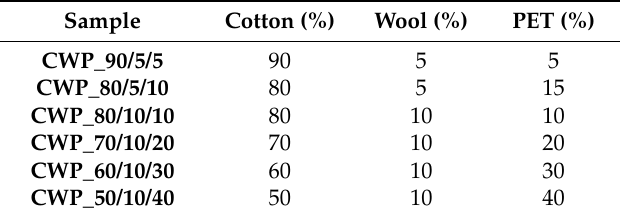
Table 1. Composition of artificial blended textile samples in weight Table 1 . Composition of artificial blended textile samples in weight percentage.